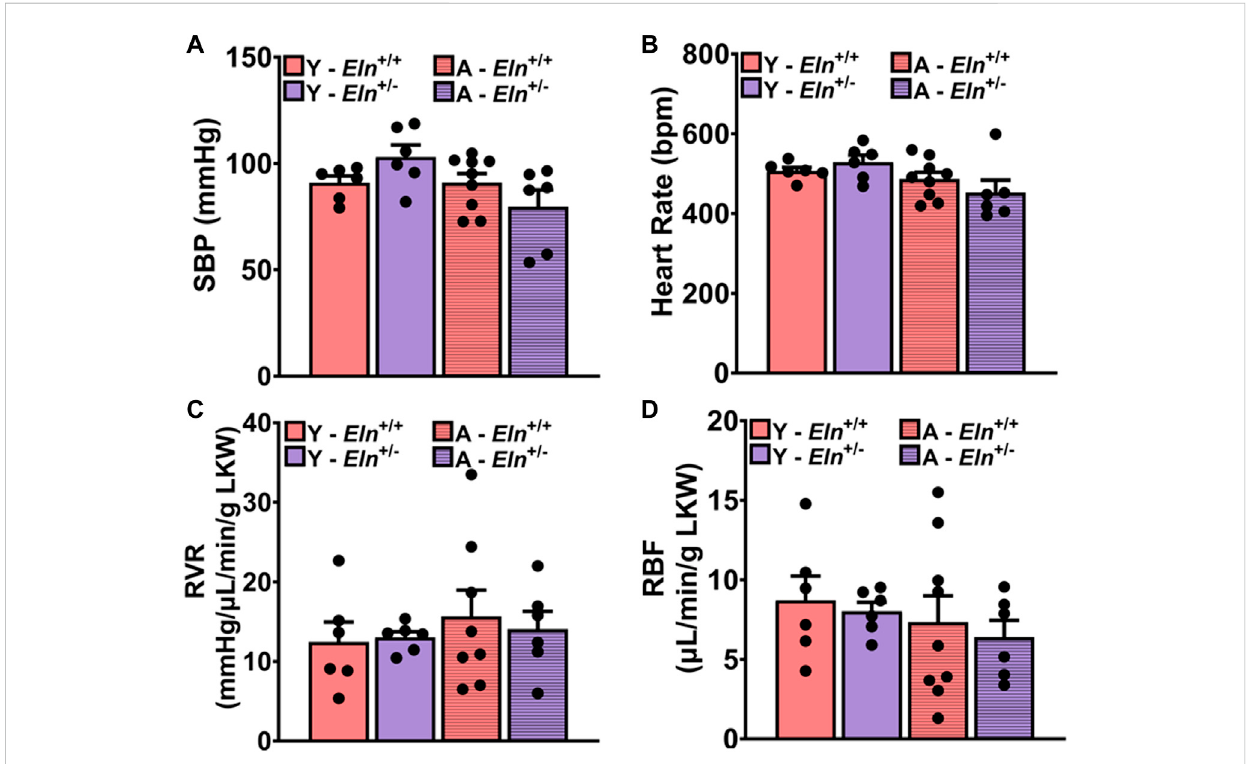
FIGURE 4 Baseline systolic blood pressure [ (A) , SBP], heart rate [ (B) , HR], renal vascular resistance [ (C) , RVR], and renal blood fl ow [ (D) , RBF] in young and aged Eln +/+ and Eln +/ − mice during systemic clamping ofneurohumoral input to thekidney with acontinuous infusion ofa vasoactive cocktail containing 1 μ g/ mL norepinephrine, 0.5 ng/mL arginine vasopressin, 0.2 mg/mL hydrocortisone, and 0.2 μ g/mL aldosterone in phosphate-buffered saline/albumin solution. Data are presented as mean ± s.e.m. Two-way analysis of variance with Sidak post hoc test was performed to compare all groups. N = 6 – 9 animals per group. Y, young; A, aged; LKW, left kidney